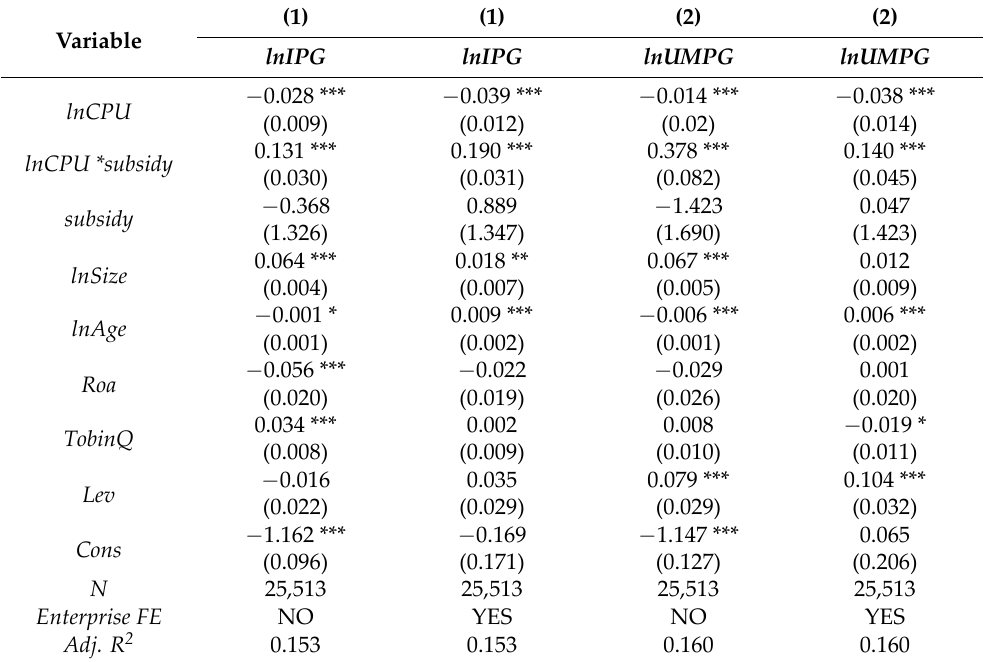
Table 6. Moderating effects test.